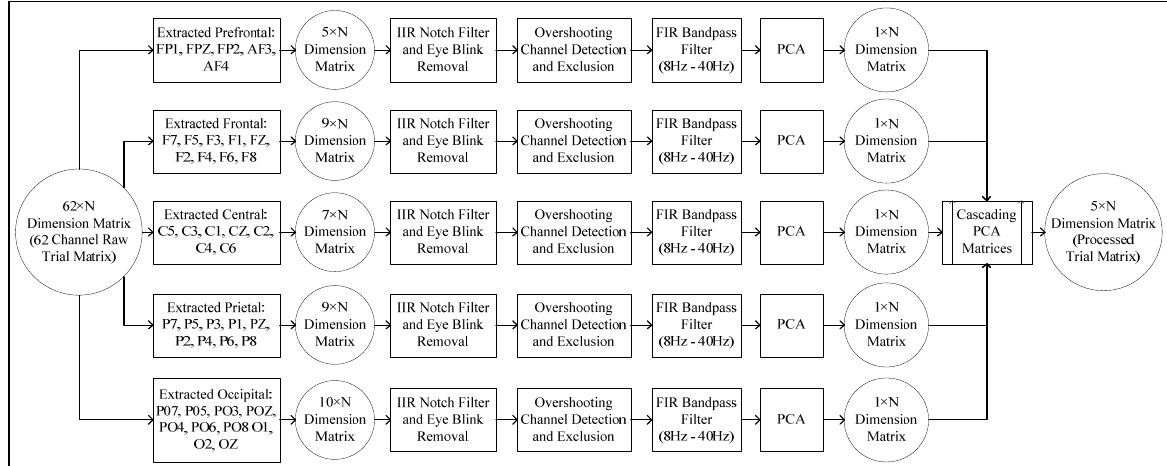
Figure 5. Flow diagram for channel exclusion and dimensional reduction.